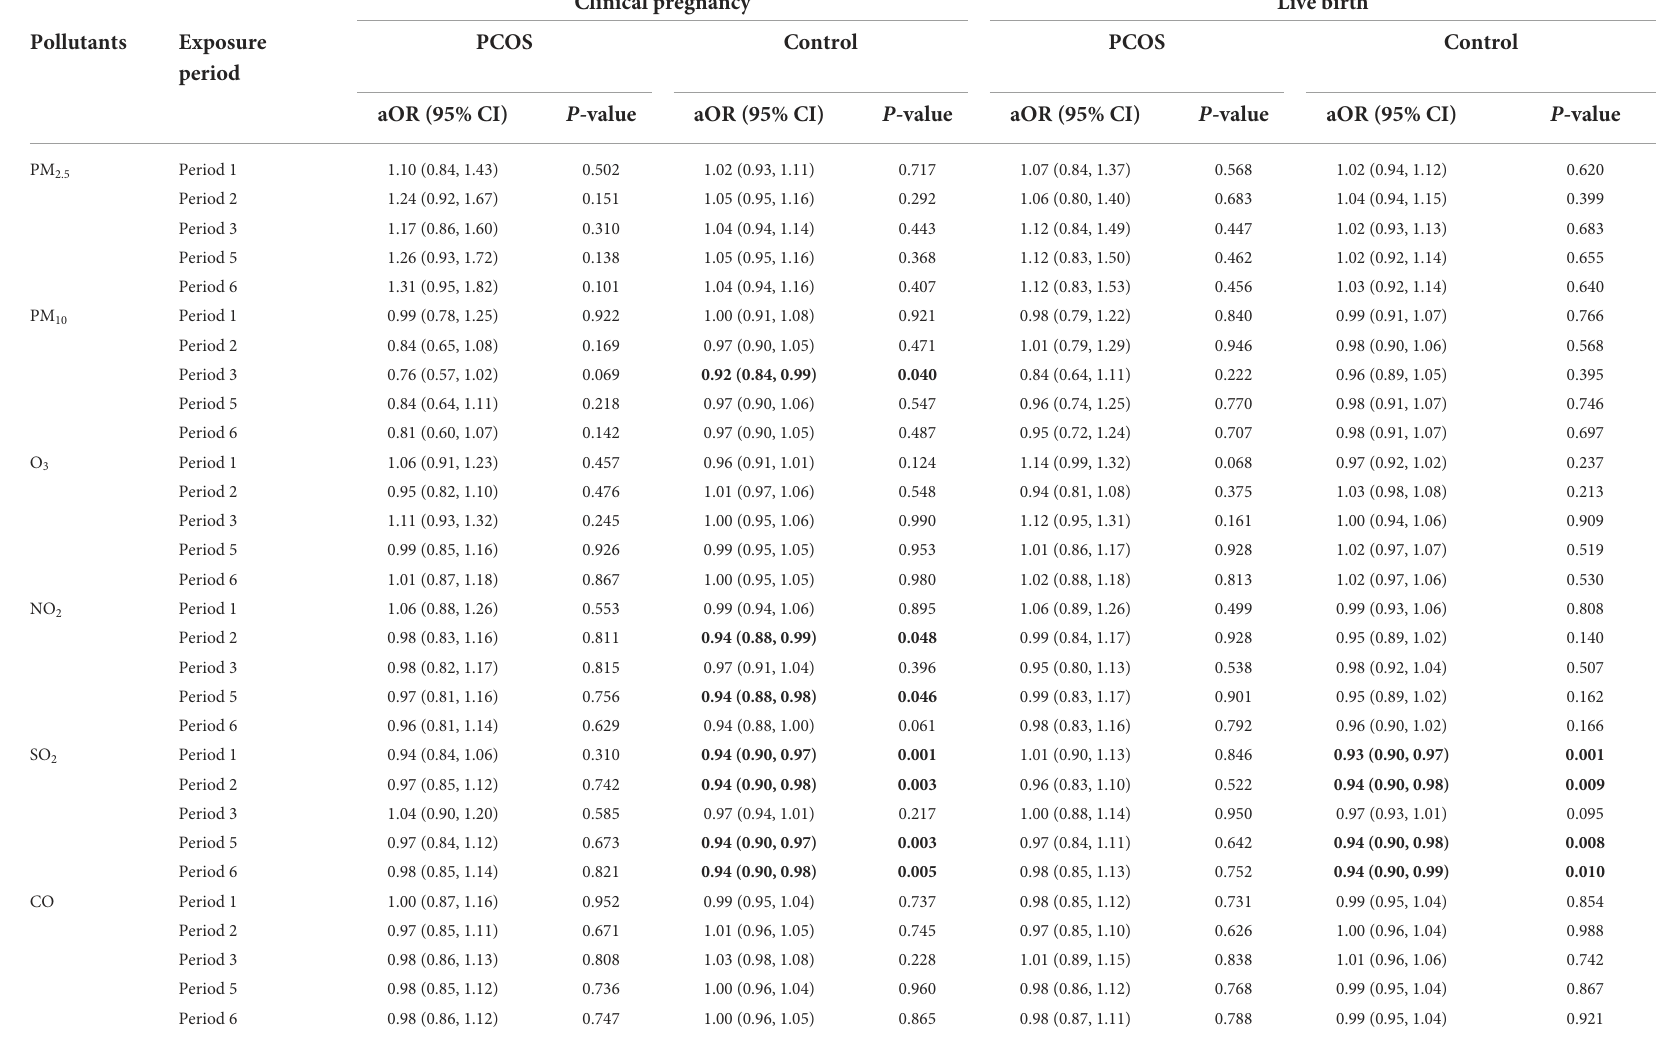
TABLE 3 Association between ambient air pollution exposure and pregnancy outcome and live birth among women with and without